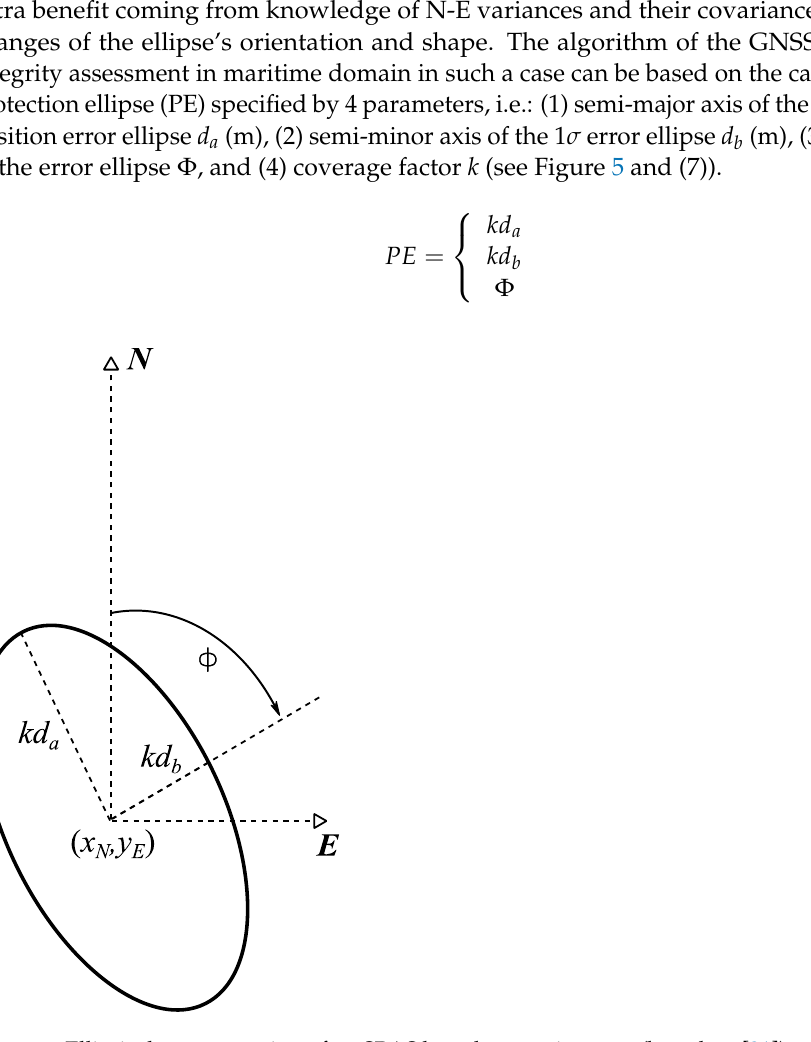
Figure 6. Example of 2D 95% and 99.99992% confidence ellipses, and AL circle for GNSS recorded data (own study).